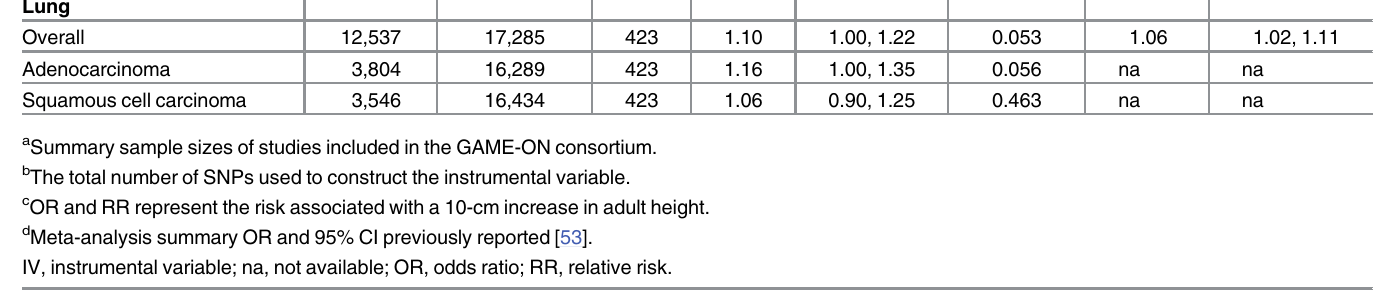
a Summary sample sizes of studies included in the GAME-ON consortium. b The total number of SNPs used to construct the instrumental variable. c OR and RR represent the risk associated with a 10-cm increase in adult height. d Meta-analysis summary OR and 95% CI previously reported